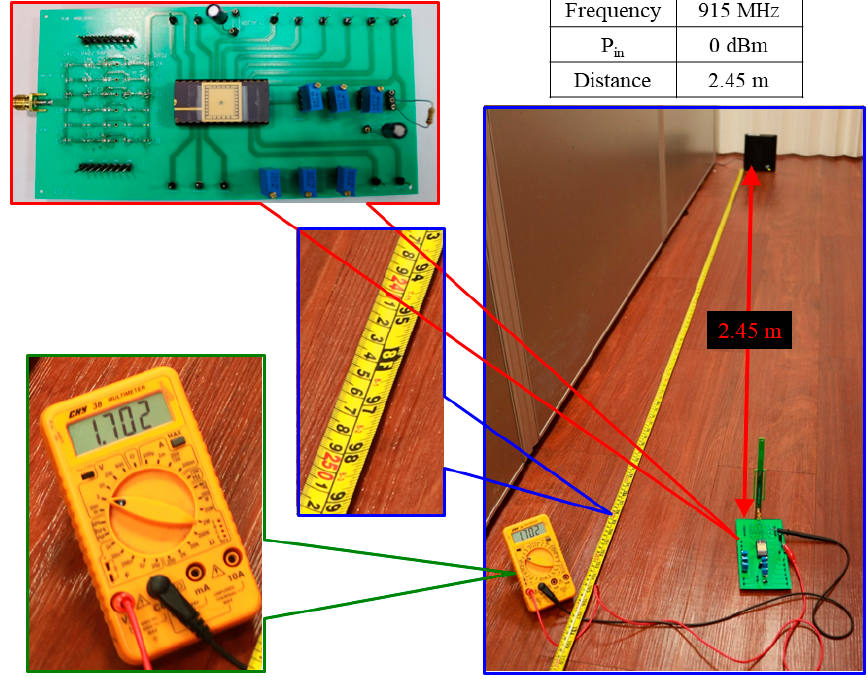
Figure 20. Measured setup of the proposed RF-energy-harvesting IC.